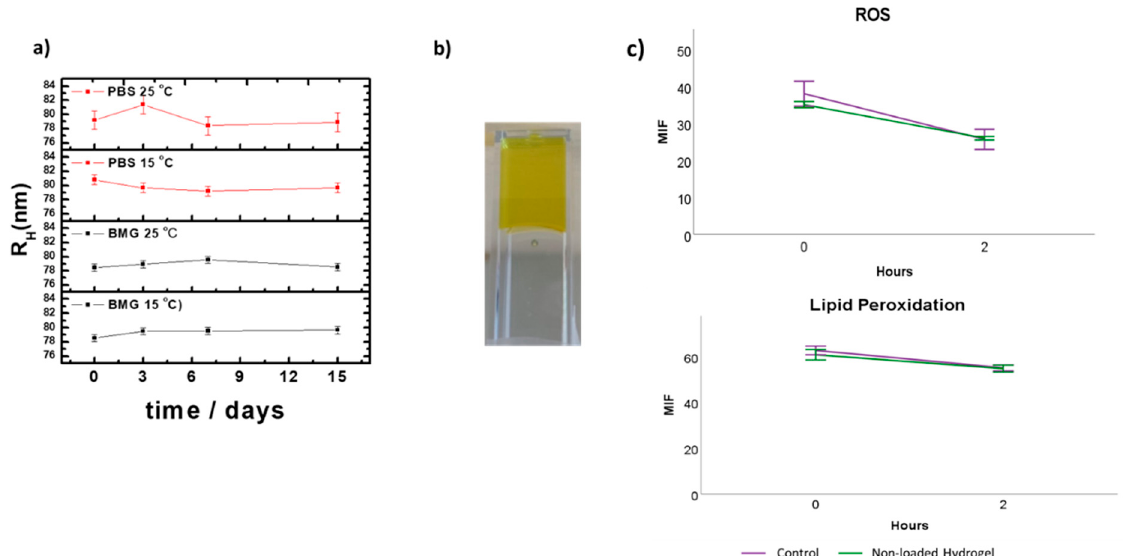
Figure 2. Stability and toxicity of the carriers:( a ) Storage stability of NVEs in PBS and BGM. Data are stated as mean ± SEM from at least three independent experiments; ( b ) image of the HVEs using test tube inversion method; ( c ) differences between control and unloaded hydrogel; ( c ) vitamin E formulation effects on ROS production and lipid peroxidation. The results show MIF (mean intensity fluorescence). Plots represent the interaction of different treatments × incubation time for the flow cytometry analysis of reactive oxygen species (median fluorescence of H2DCFDA in PI − sperm) and lipid peroxidation (median green fluorescence of BODIPY C11).